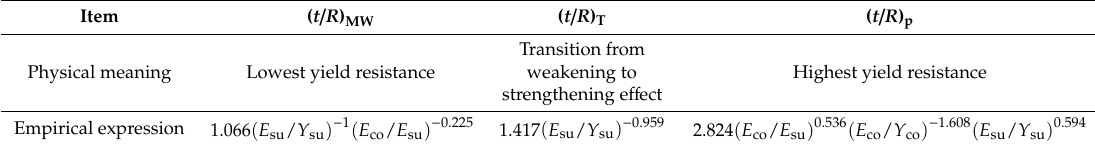
Table 1. A summary of physical meaning and empirical expressions of ( t / R ) MW , ( t / R ) T and ( t / R ) T in